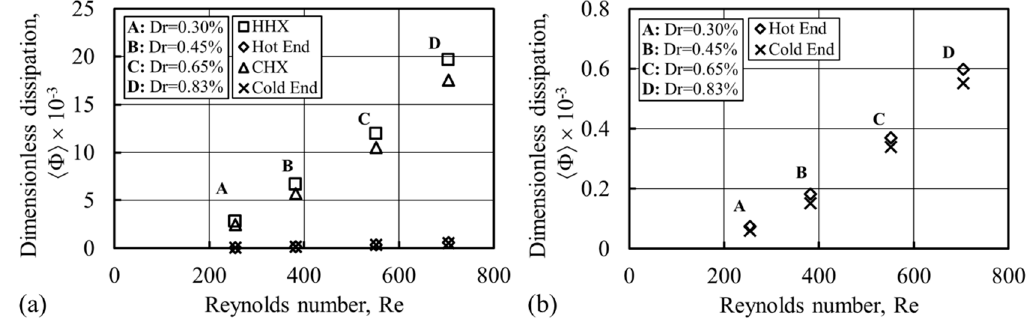
Figure 18. The effect of the drive ratio on dimensionless mean flow viscous dissipation ( a ) and the enlarged view of the viscous dissipation at the end of plates ( b ).